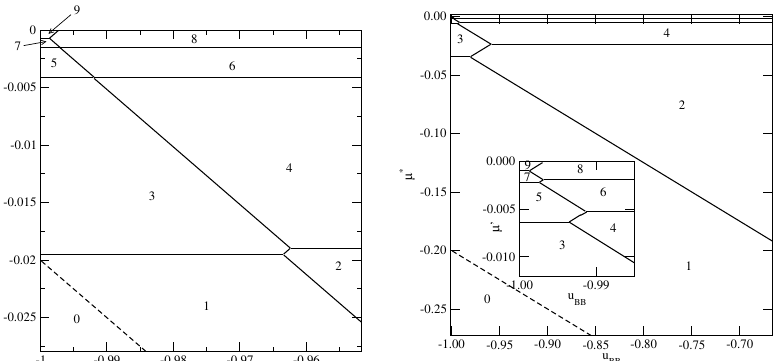
Figure 7. The ground state phase diagrams for the systems with V A = − 0.01 and V B = − 1.02 ( left panel) and with V A = − 0.2 and V B = − 1.2 ( right panel). The inset in the right panel shows the behavior in the region of u BB close to − 1.0. The numbers mark in the figure the numbers of occupied layers in different regions.